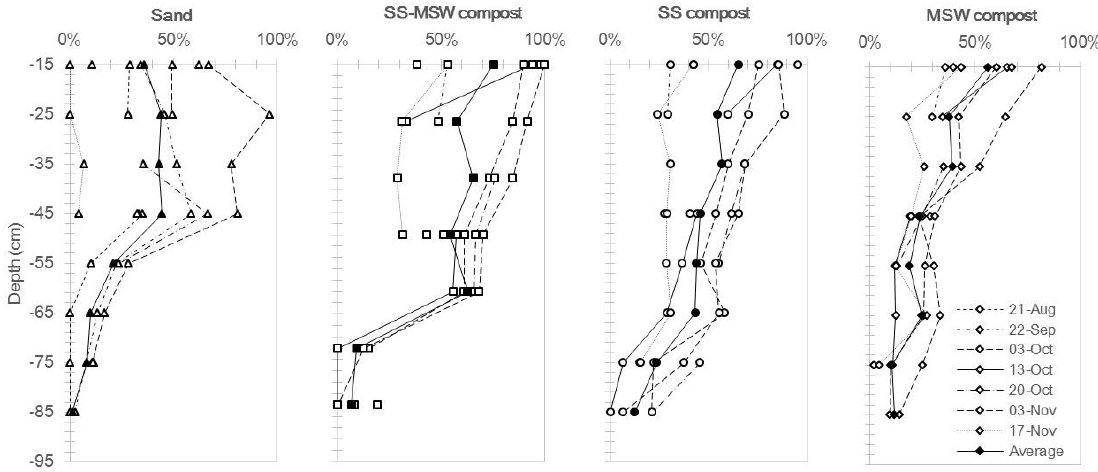
Figure 5. Methane oxidation efficiencies.